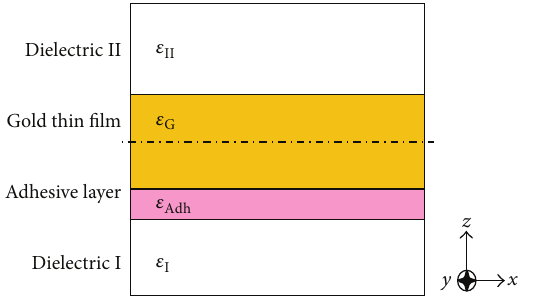
Figure 3: Practical waveguide structure (SPR), from up to down: dielectric II, gold, titanium and then dielectric